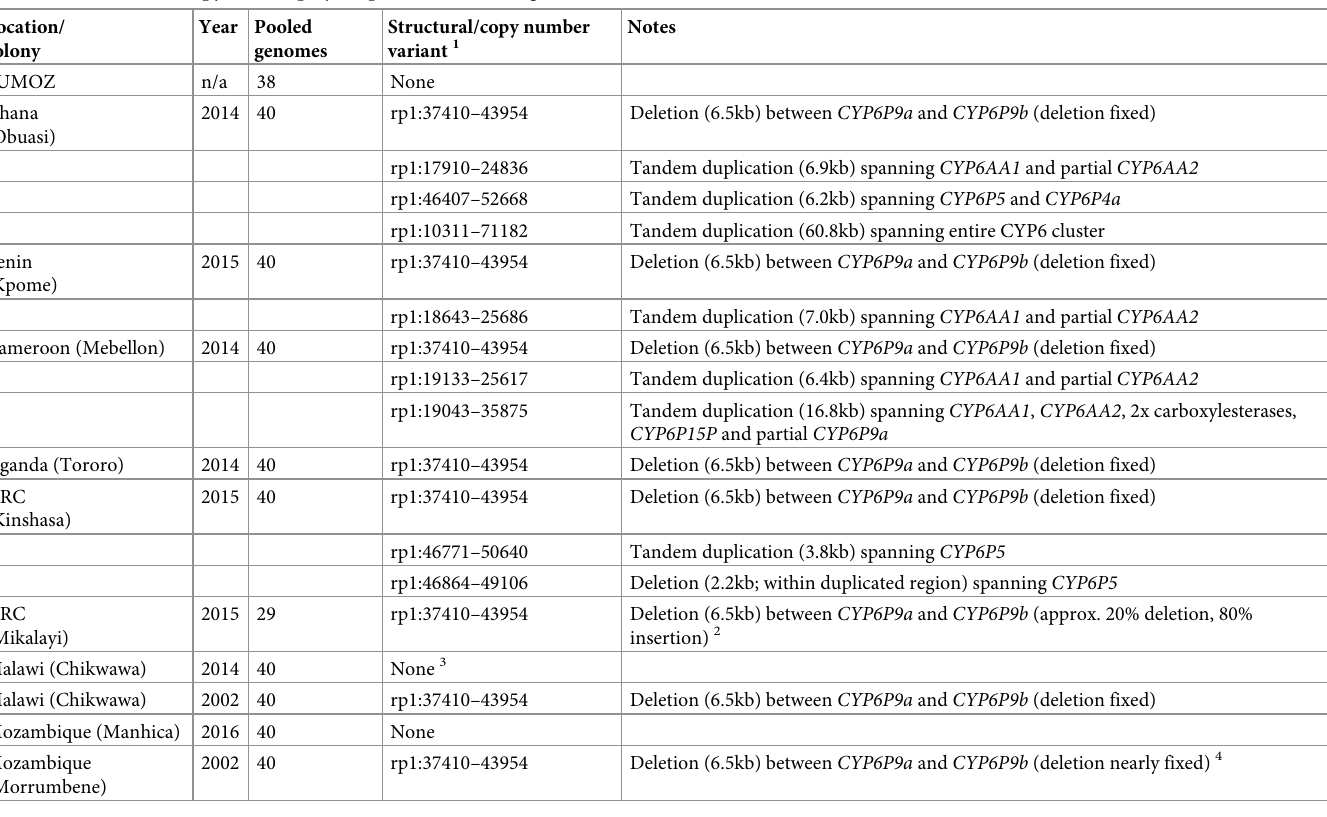
Table 1. Structural and copy number polymorphism in the CYP6 gene cluster. Location/